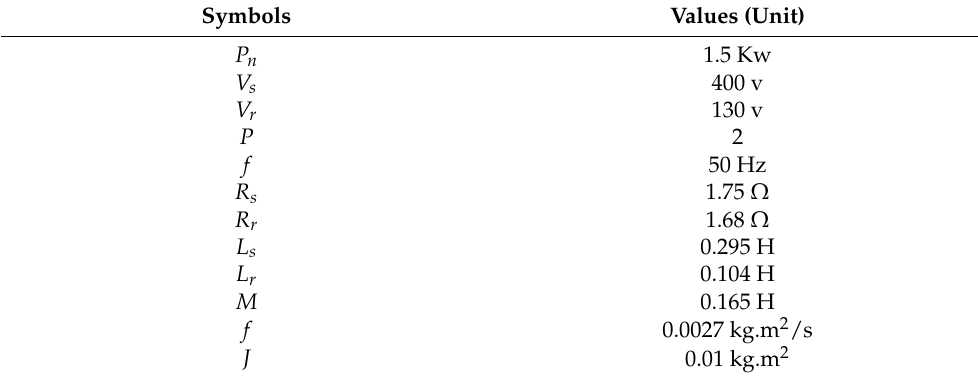
Table A1. DFIM parameters.